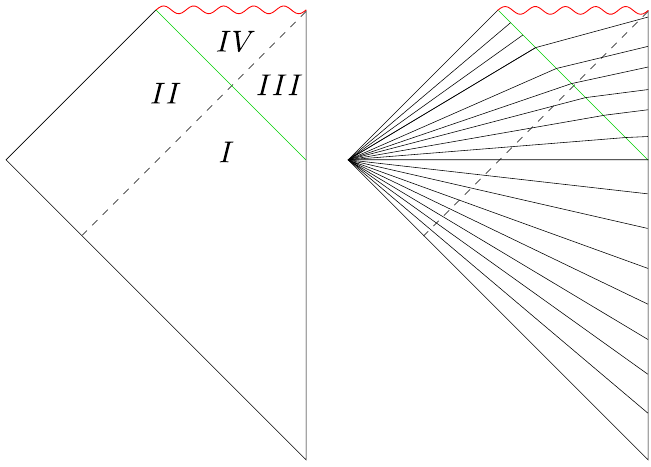
Figure 7 . Penrose diagram and extremal Cauchy slices for AdS-Vaidya. We label regions of the penrose diagram I (cid:0) IV . There is a maximum boost angle after which the extremal geodesics don’t reach the